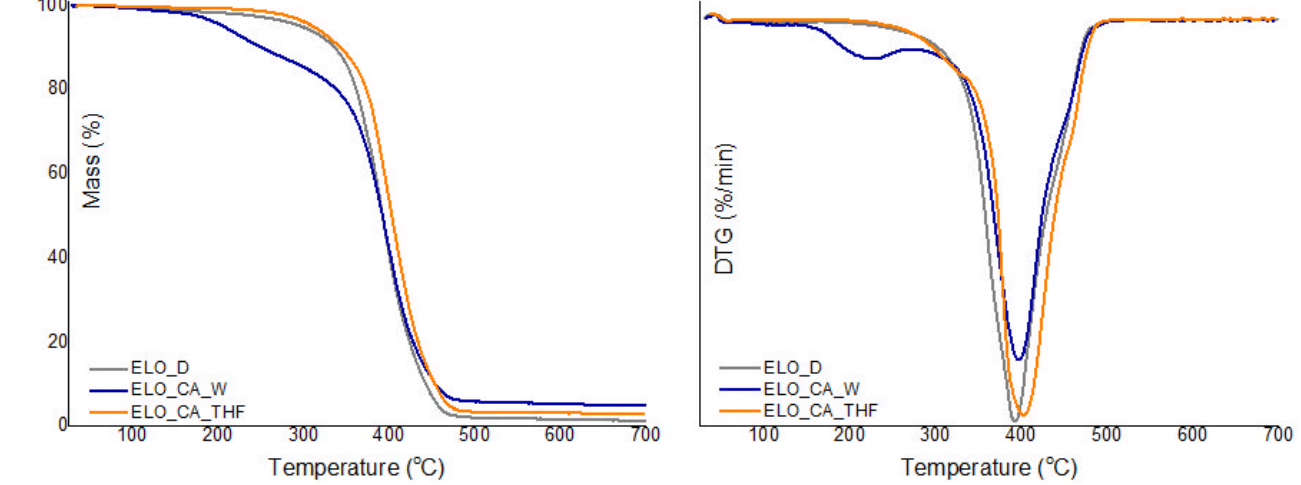
Figure 5. ( a ) TGA and ( b ) DTG curves of the studied bio ‐ based epoxy matrices. Figure 5. ( left ) TGA and ( right ) DTG curves of the studied bio-based epoxy